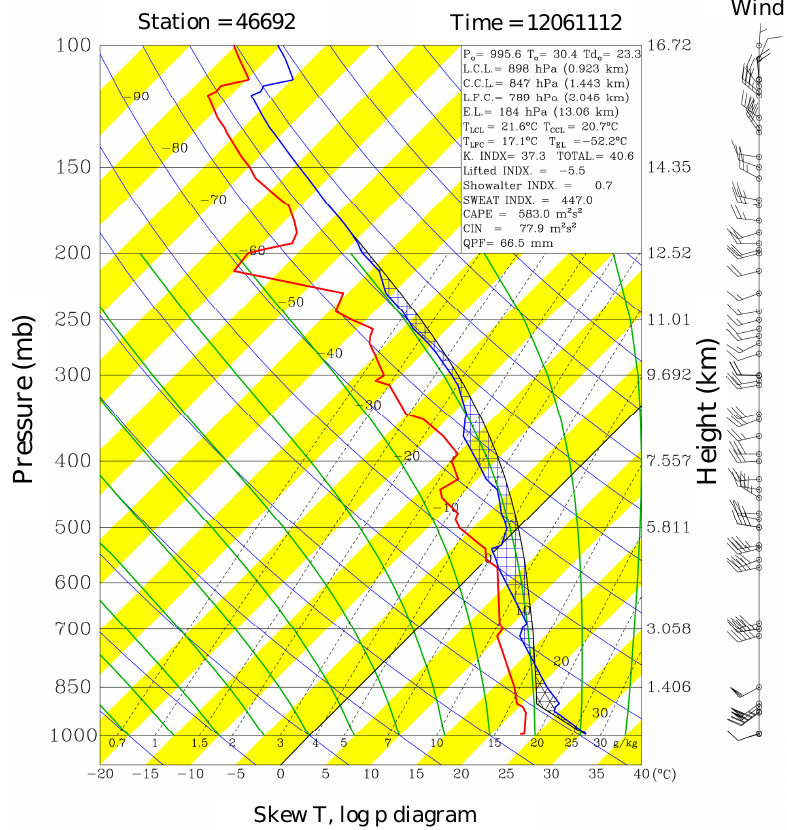
Figure 3. Thermodynamic (skew T -log p ) diagram for the sounding taken at Panchiao (46692, cf. Fig. 2c for location) at 12:00UTC on 11 June 2012. For winds, full (half) barbs denote 10 (5)kts (1kt = 0.5144ms − 1